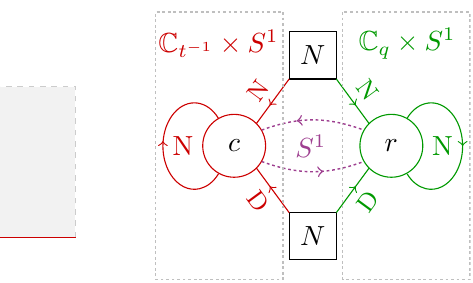
Figure 4 . On the left is a cartoon and the toric diagram of the bulk space C 2 1 ) subspace ( C ( C q S 1 ) C 2 q;t S 1 , with the intersection given by O t (cid:0) 1 (cid:2) S [ (cid:2) (cid:26) (cid:0) 1 (cid:2) Both C q S 1 and C t S 1 harbor respectively a 3d U( r ) and U( c ) gauge theory. The two gauge (cid:2) (cid:0) 1 (cid:2) theories interact through a pair of 1d bifundamental chiral multiplets living at the intersection S 1 . On the right is the quiver diagram describing the intersecting gauge theories that enter into the expansion. The boundary conditions for various chiral multiplets are labeled explicitly, and the 1d chiral multiplets are denoted by the pair of purple dotted arrows in the